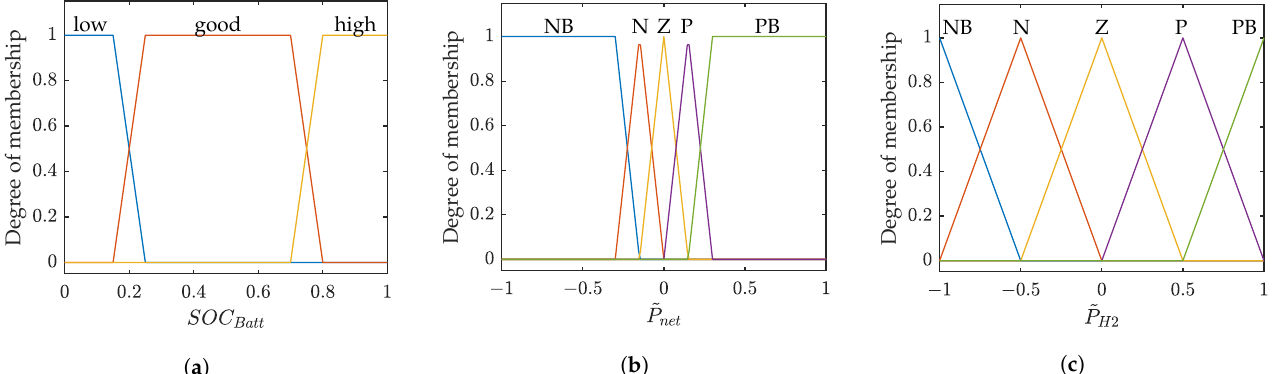
Figure 3. Membership functions. ( a ) Input 1: battery state of charge (SOC). ( b ) Input 2: net power ˜ P net . ( c ) Output: electrolyzer/fuel cell power ˜ P H 2